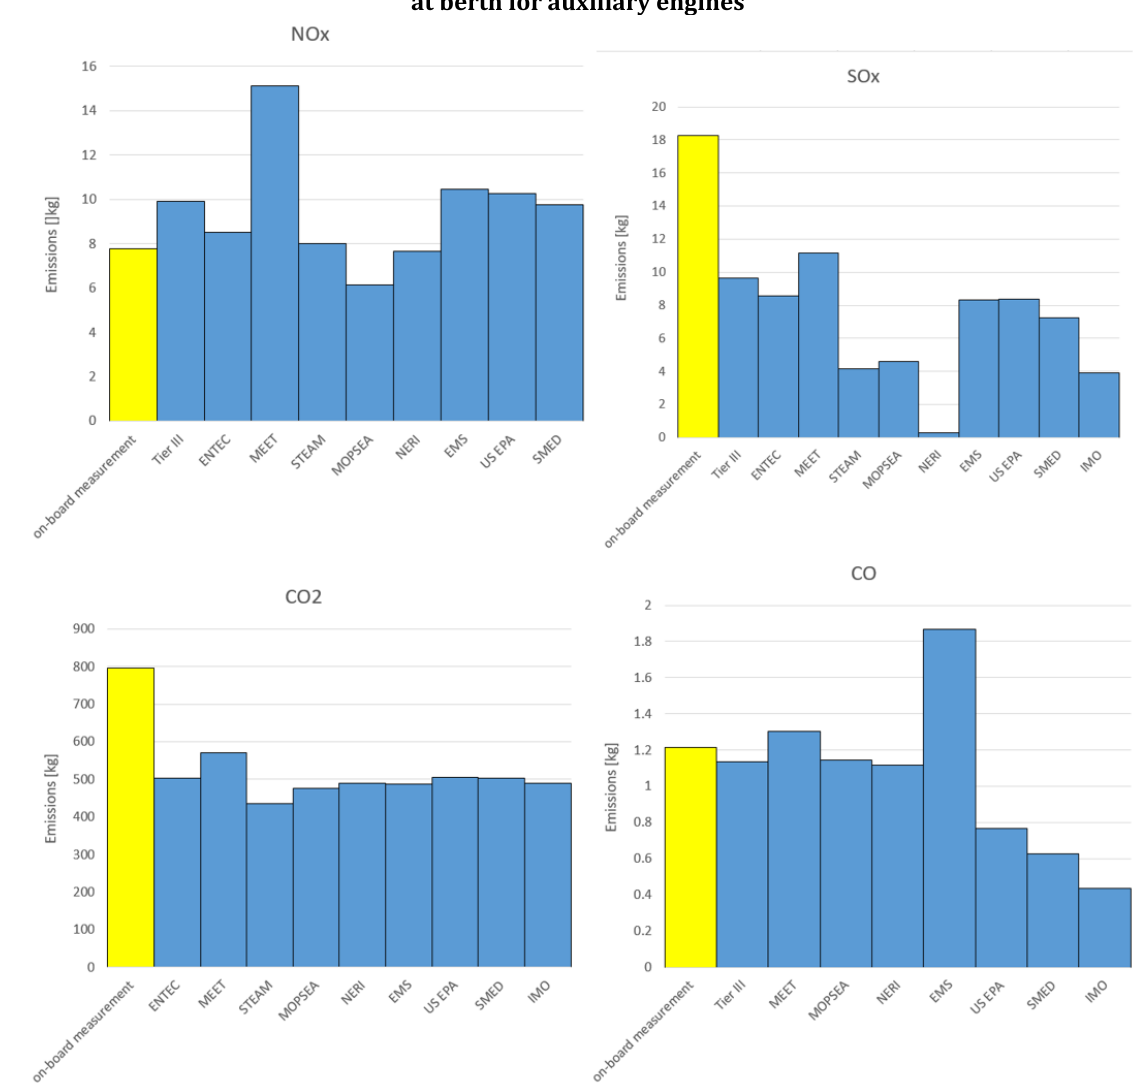
Figure 2: Total Emission amounts’ measurement and inventory prediction at berth for auxiliary engines